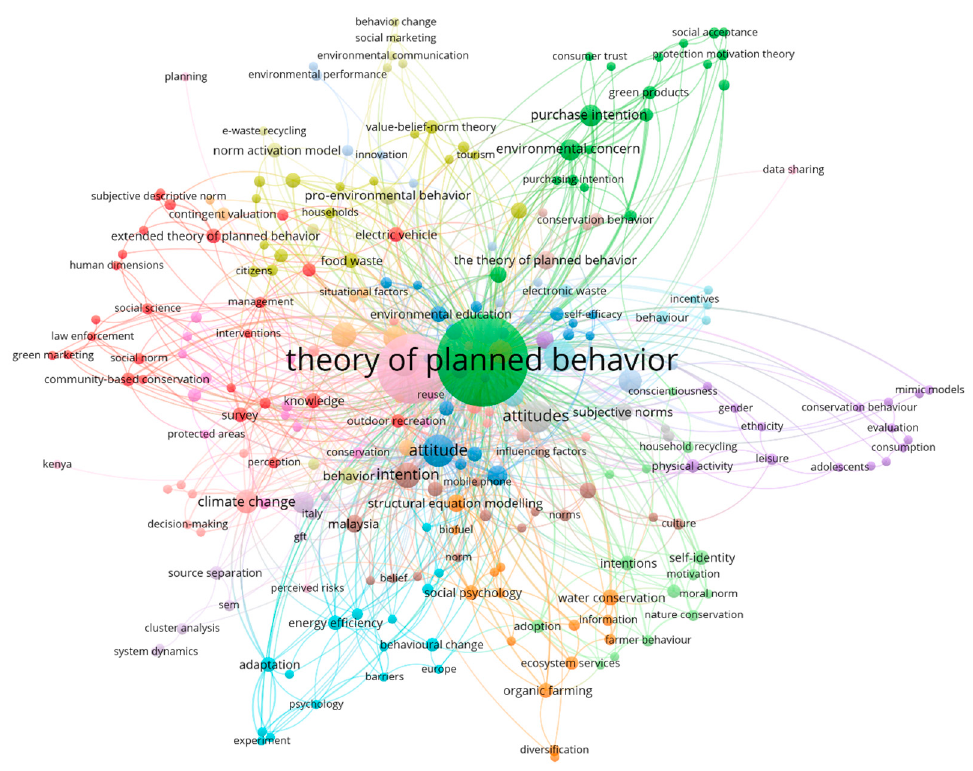
Figure 8. Author keyword co-occurrence network.